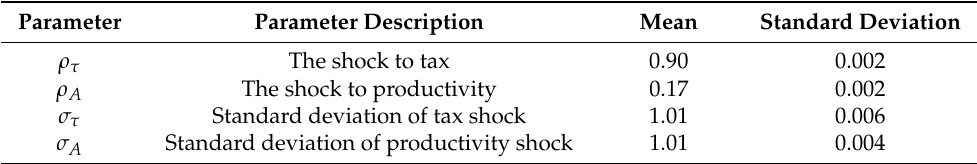
Table 4. Parametric estimates obtained from Bayesian